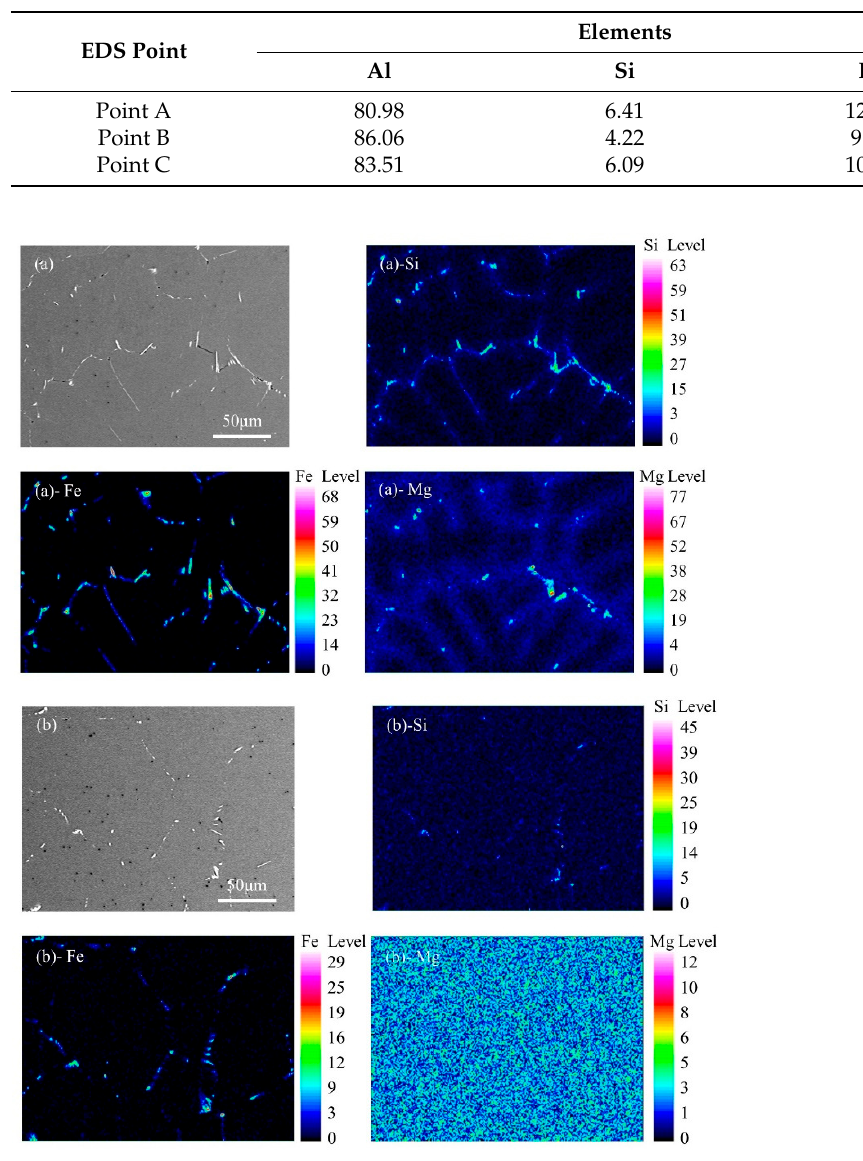
Figure 8. Distribution of solute elements in the specimens. ( a ) As cast; ( b ) homogenized.